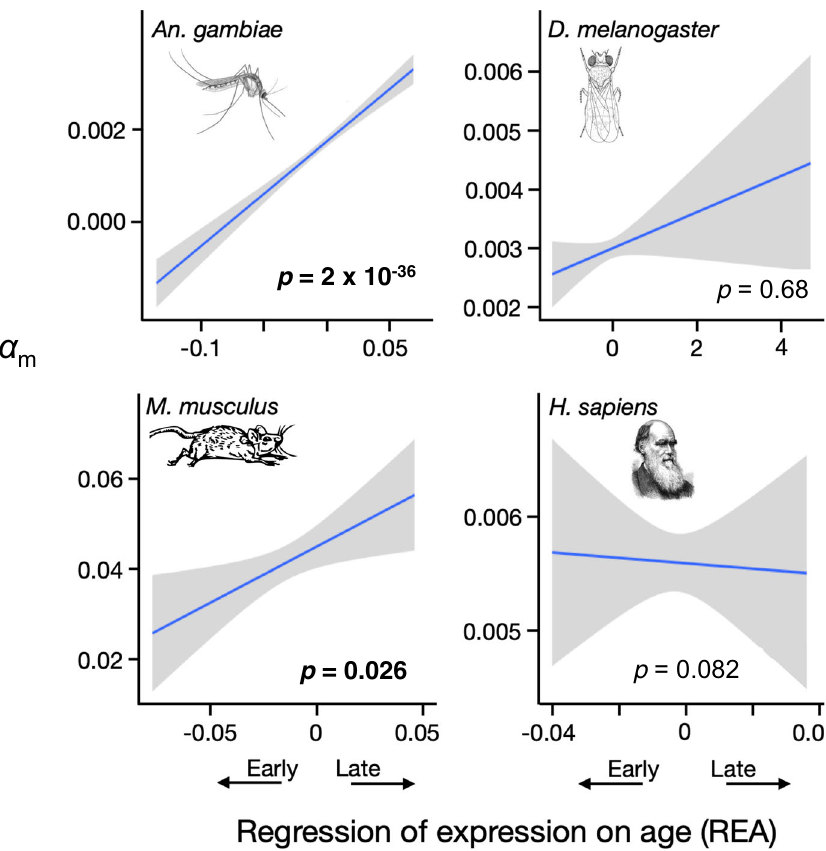
Fig. 6 Late genes fi x bene fi cial mutations more often. The fraction of nonsynonymous mutations that are bene fi cial ( α m ) is signi fi cantly greater in late- expressed than early-expressed genes in two of the four species. Signi fi cance was determined by Spearman rank correlations, and p -values in bold are signi fi cant at p < 0.05 (two-sided tests, not corrected for multiple tests). The lines are least squares regressions, and the gray regions show the approximate 95% con fi dence intervals for the regressions. See also Supplementary Fig. 6 and Supplementary Table